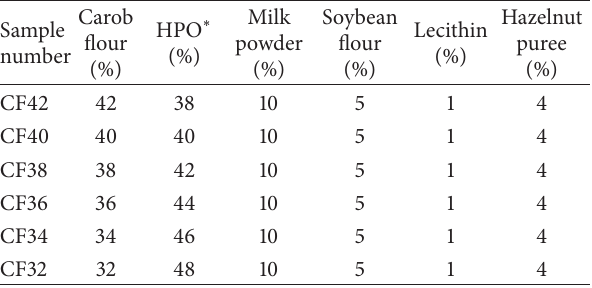
Table 1: Percentage of ingredients in